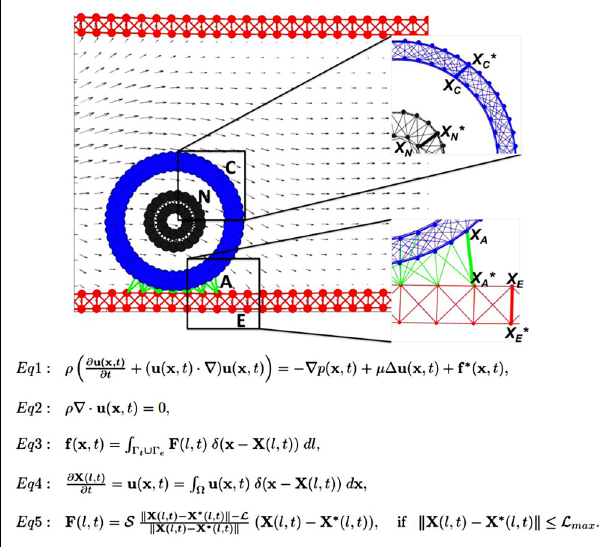
FIGURE 1 | Model schematics and equations. A schematic representation of the 2D model of the tumor cell in circulation.The blood vessel (red walls, E) is interpenetrated by a laminar flow (gray arrows representing blood velocity field) that interacts with a circulating tumor cell (CTC).The cell nucleus (gray, N) is surrounded by the cell cortex (blue, C) that both define cell shape and stiffness.The cell near the endothelial wall (EW) develops CTC–EW adhesive connections (green links, A). Insets show the magnification of a meshwork defining the nucleus and the cortex (top), and the network defining the EW and CTC–EW adhesive springs (bottom). Representative springs of the cortex, nucleus, endothelium, and adhesive CTC–EW links (X C –X C *, X N –X N *, X A –X A *, X E –X E *) are indicated by thick lines. Equations 1–5 define the mathematical frameworks of the Immersed Boundary